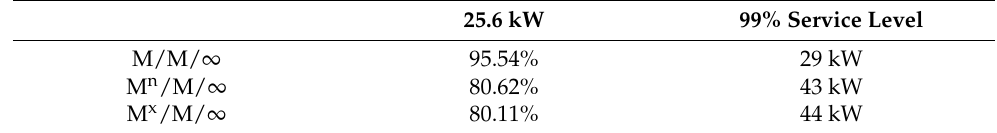
Table 6. Comparison of the calculated service levels of the three models.